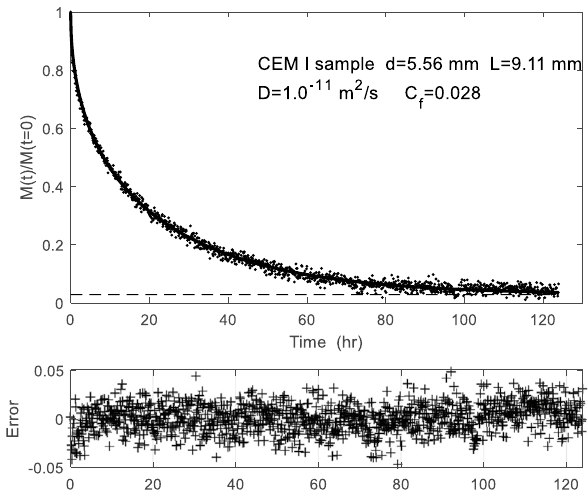
Fig. 18 Diffusion curve on a Portland cement paste (CEM I type). The magnetization amplitude is obtained from FID recordings with a short repeat delay between scans to not polarize long compo- nents. The dashed line indicates the fitted asymptotic value M(t = ∞ )/M(t = 0). The lower panel shows the error between the model and the data. The T 2 relaxation time distribution of this sample is centered around 0.1 ms—Oxford